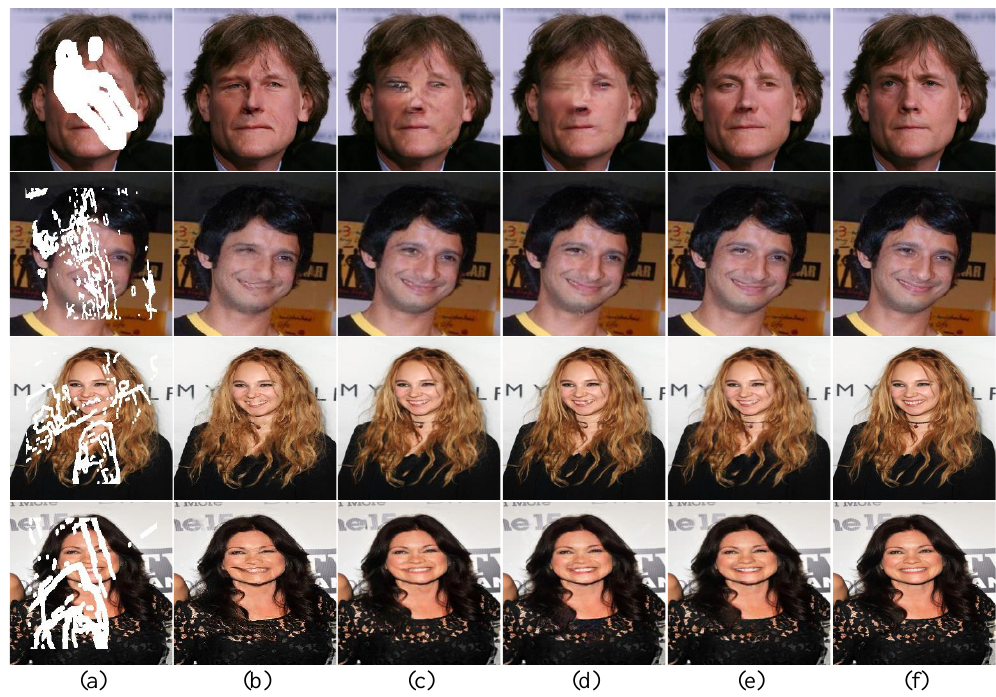
Figure 6. Comparison on the CelebA dataset. ( a ) Input images. ( b ) GC [13]. ( c ) EC [8]. ( d ) MED [6] ( e ) Ours. ( f ) Ground